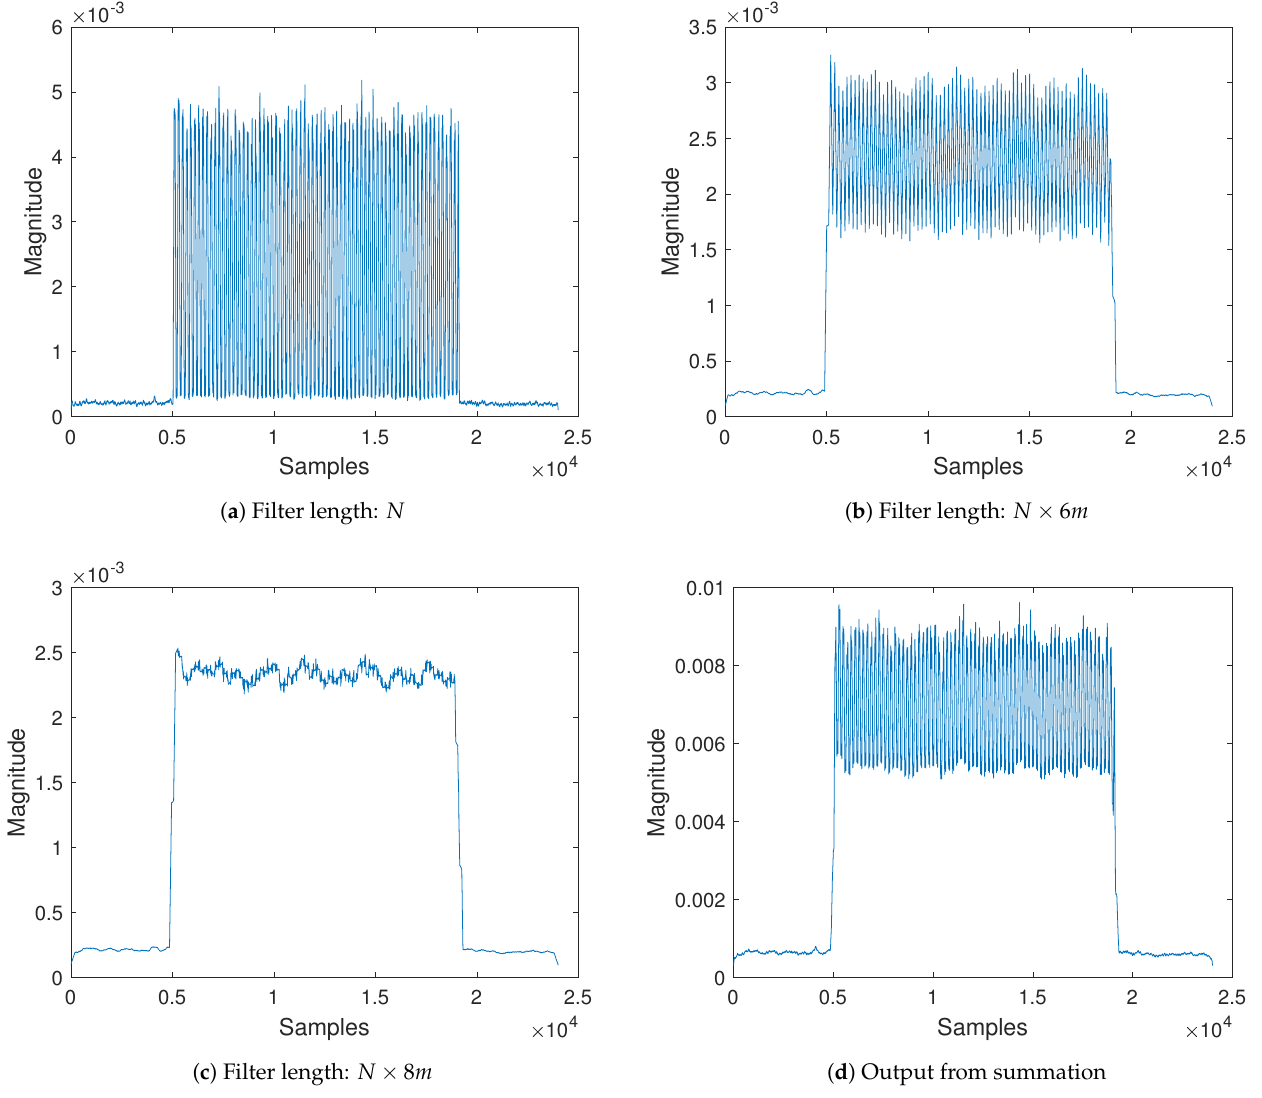
Figure 6. Filtered signal design of the summation